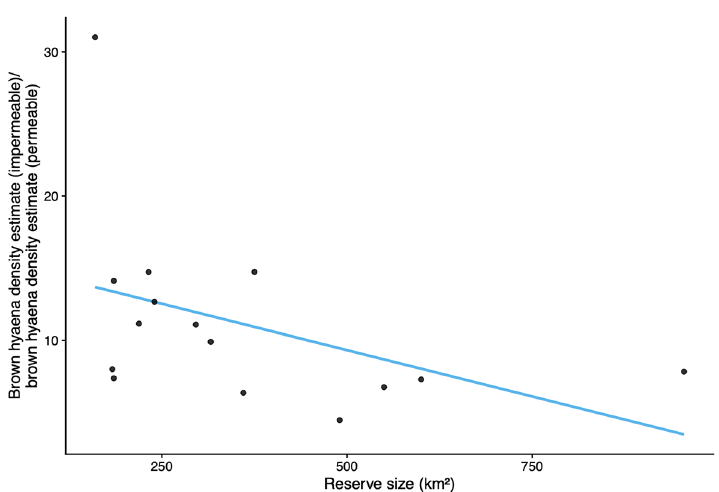
Figure 3. Relationship between reserve size and the ratio of brown hyaena population density estimates when using differing assumptions of fence permeability.